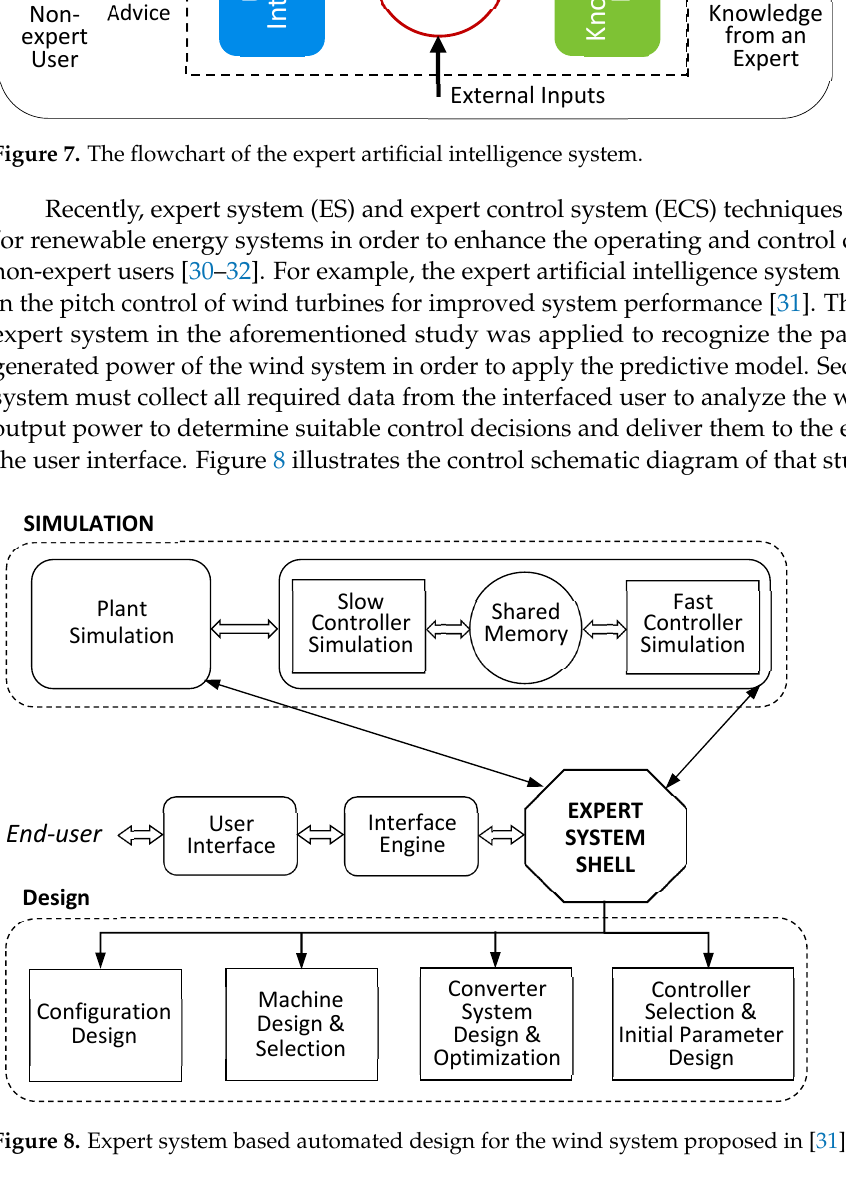
8 of 18 Figure 6. Percentage of normalized PV output power versus dust weight: (starred black) collected data, (dotted red) fitting curve. 4. Artificial ‐ Intelligence ‐ Based Prediction Model The main objective of this paper is to give optimized decisions on the cleaning of PV panels, using a fewer number of external measuring elements, with the help of an intelli ‐ gent computational engine. Hence, this section demonstrates the methodology of gather ‐